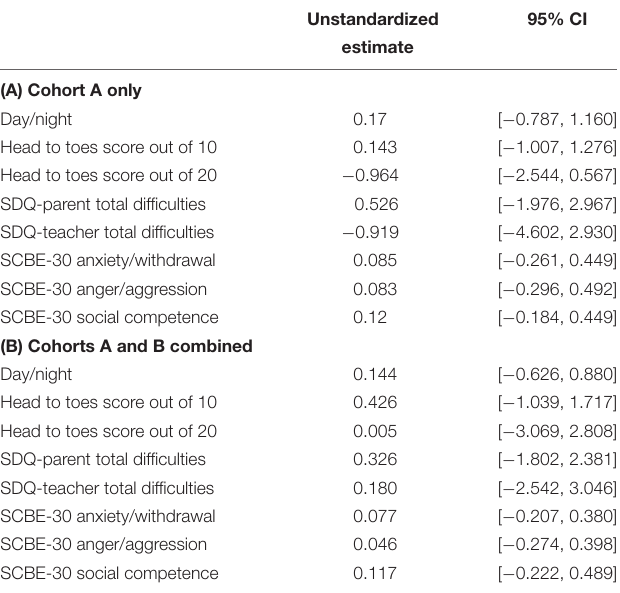
TABLE 3 | Results for main effect of curriculum. Unstandardized 95%